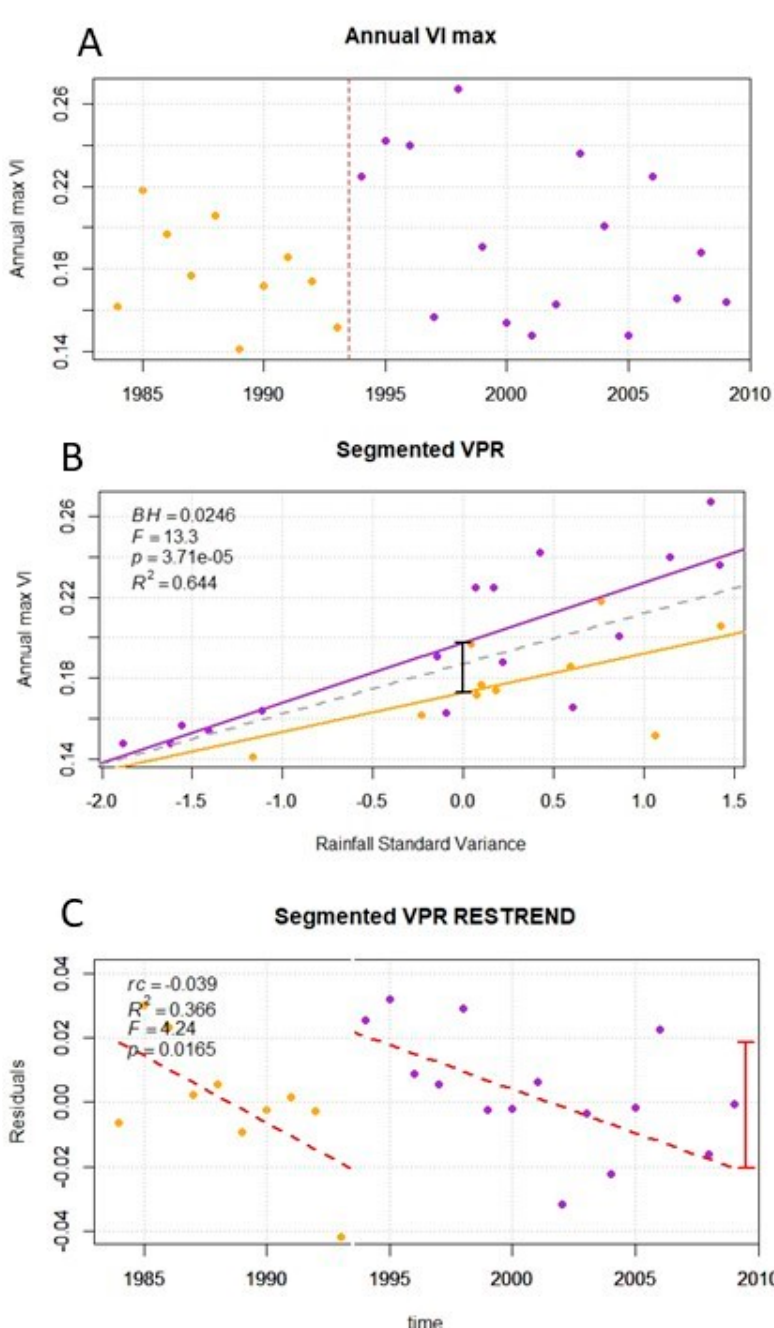
Figure 8. An example pixel from western Xilingol with a breakpoint in the VPR. The geographic location of the pixel is (113.189°E, 43.405°N, 113.26°E, 43.335°N). ( A ) NDVImax vs. time. The vertical red dotted line shows the position of the detected breakpoint (break year = 1993). ( B ) The change in the VPR before (orange) and after (purple) the breakpoint. The dotted grey line represents the VPR that was fitted to the data by a standard RESTREND and the black bar represents the break height (BH = 0.0246). ( C ) The segmented RESTREND applied using the segmented VPR. The red bar indicates the residual change (rc = − 0.039). The total change is calculated by adding the VPR break height (BH) to the residual change (rc). So the total change is T.C. = − 0.0144.